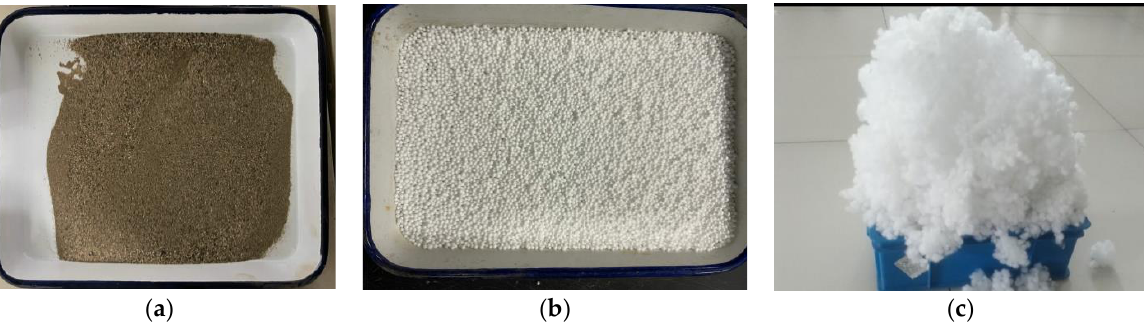
Figure 3. Sand, EPS beads, and flocculent EPE materials. ( a ) Sand; ( b ) EPS beads; ( c ) flocculent EPE.